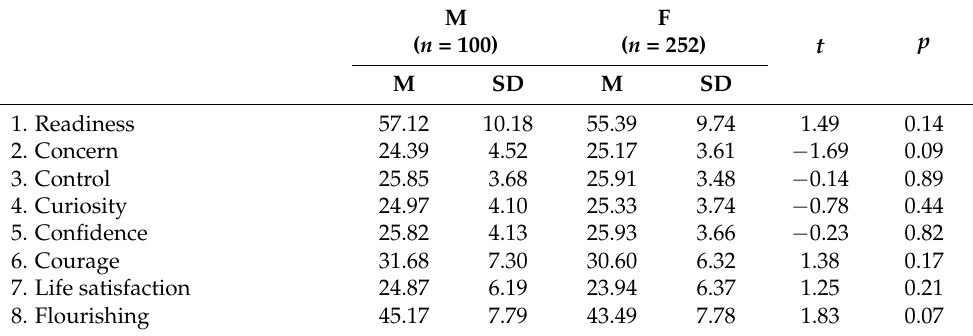
Table 2. Gender differences in the dimensions of the study (Student’s t test, p < 0.05).